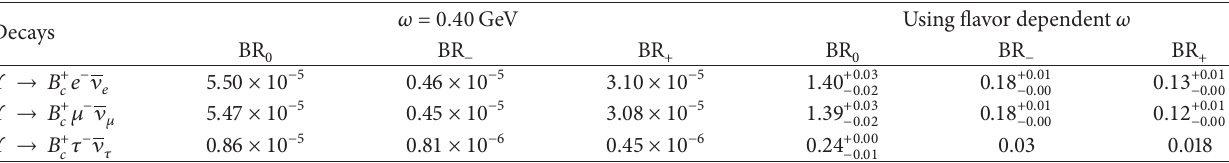
Table 10: Branching ratios BR 0 , BR − , and BR + corresponding to the Helicity amplitudes ℎ 0 and ℎ ±1 (in the units of 10 −10 ) of Υ → 𝑃𝑙𝜈 decays.